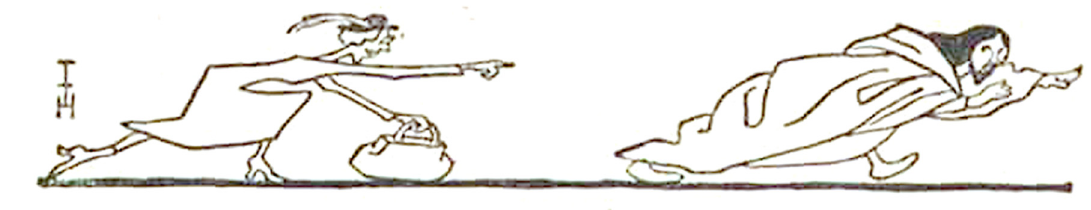
Figure 3. Simplicissimus 26, 53: 2.